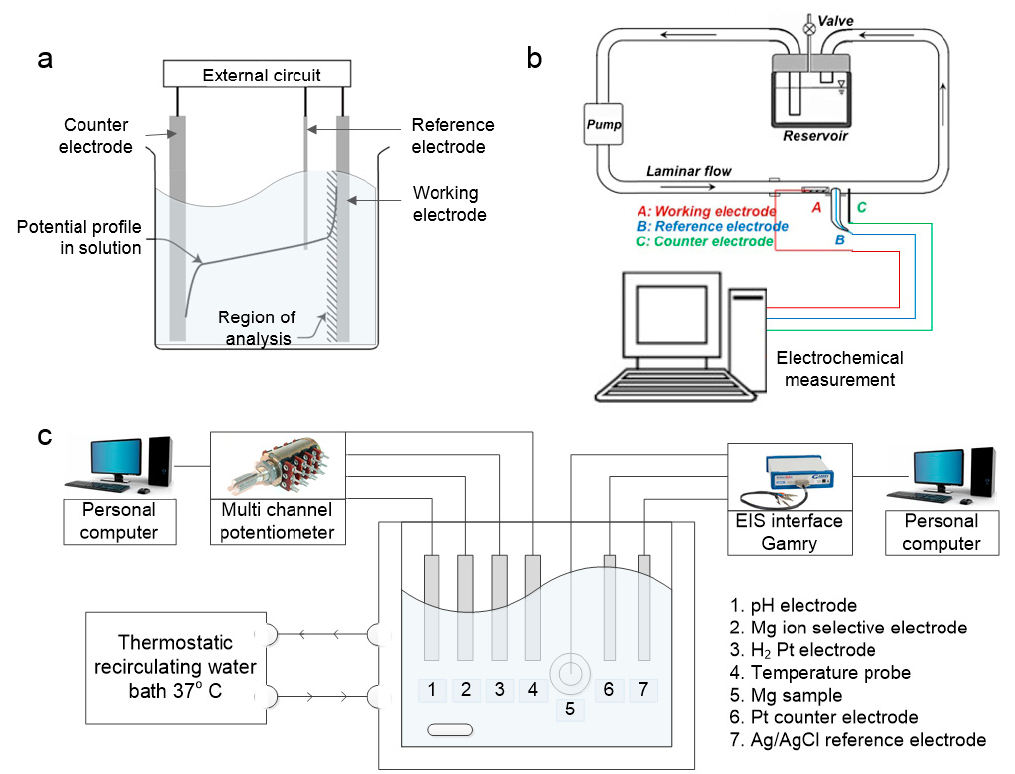
Figure 6. Electrochemical-based monitoring systems: ( a ) a three-electrode electrochemical cell of amperometric sensor; ( b ) an experimental setup to study the dynamic corrosion of an absorbable metal in-situ and in real time; ( c ) a corrosion characterization system instrument and cell configuration. Adapted with permission from Elsevier [39,66,67].